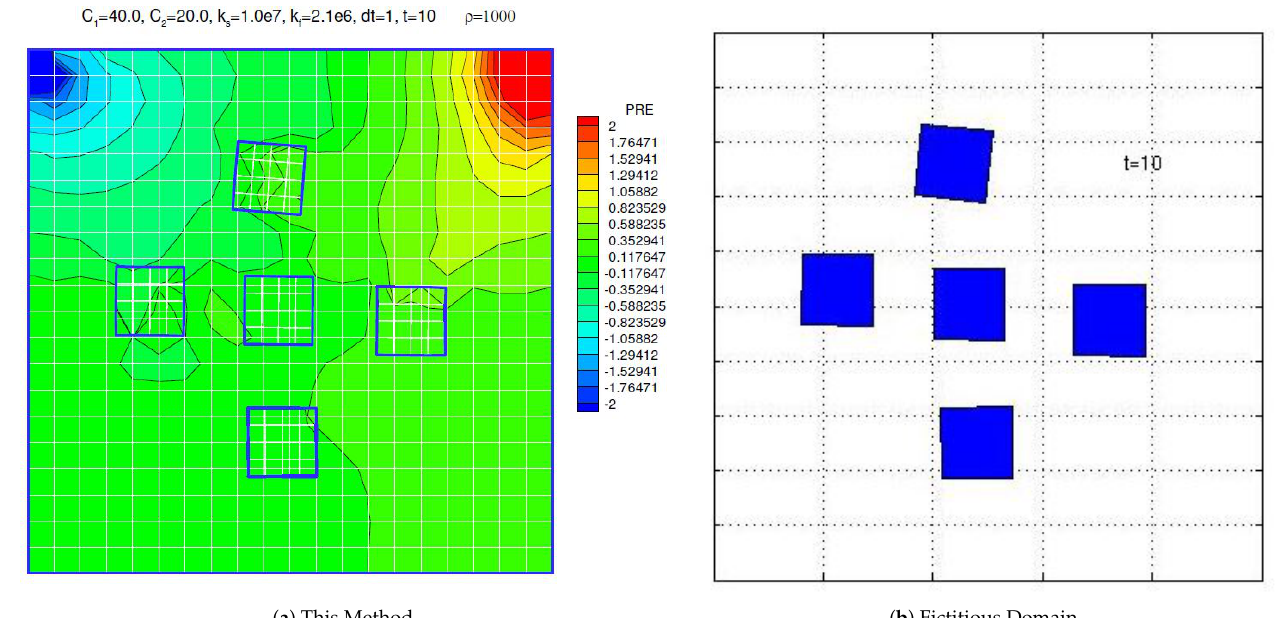
Figure 11. Driven cavity with five compressible immersed